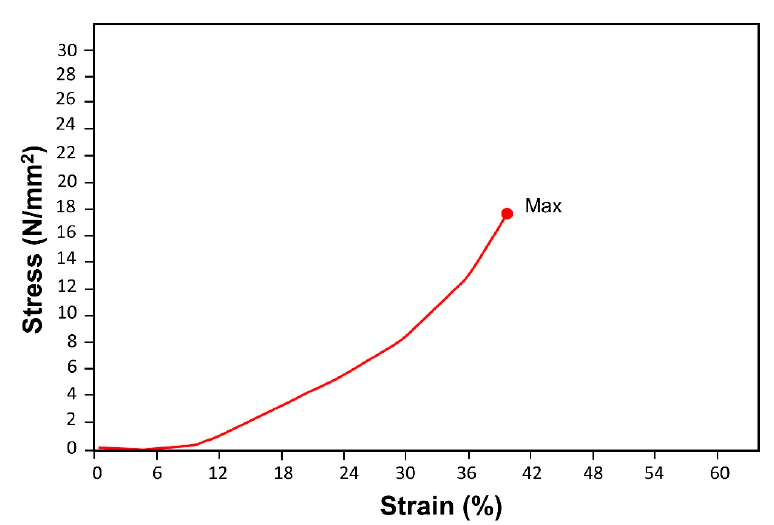
Figure 9. Compression test graph of phenol-furfural resin / organo modified MMT clay based high-pressure composite by UTM.